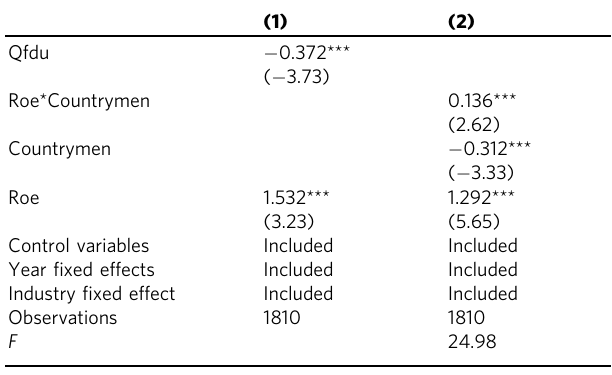
The OLS method uses the pooled regression while controlling for industry and year effects. The t -statistics are shown in parentheses. Beta coef fi cients are indicated at the 1% levels of signi fi cance by ***